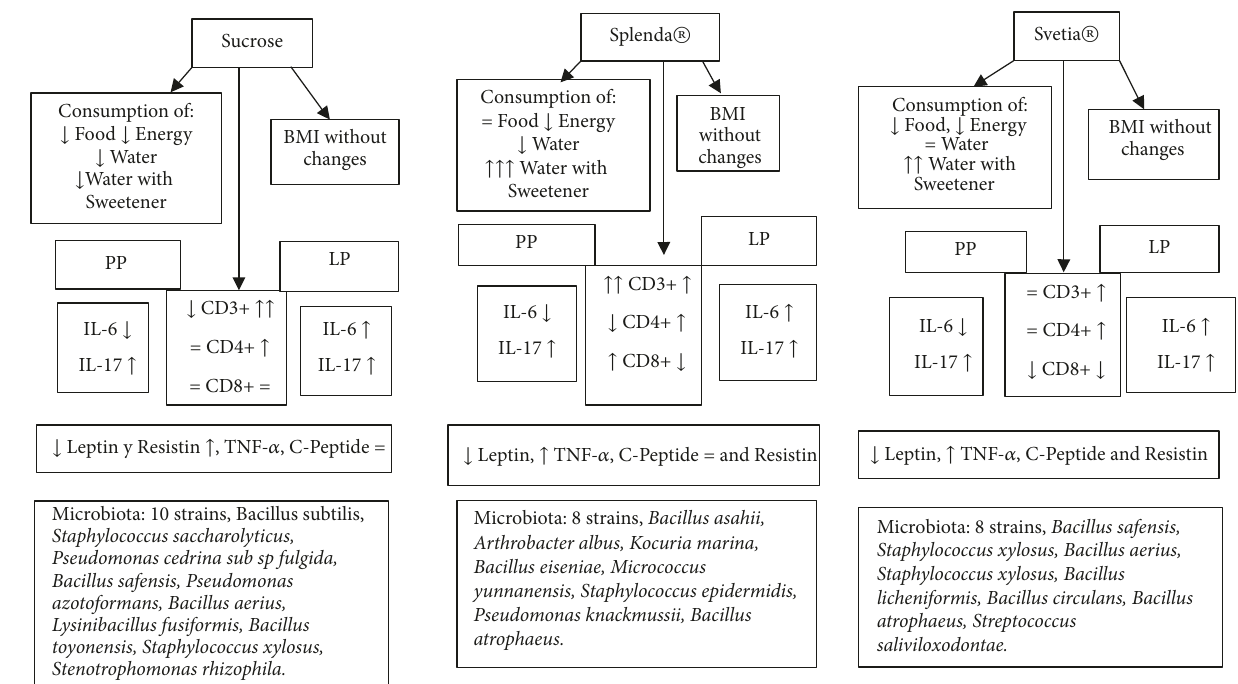
Figure 2:Representing the integrationof quantified parametersafter6 weeks of supplementationwith sweeteners.Peyerpatches(PP), lamina propria (LP), interleukin-6 (IL-6), interleukin-17 (IL-17), and Cluster of Differentiation 3, 4, 8 (CD3+, CD4+, and CD8+).